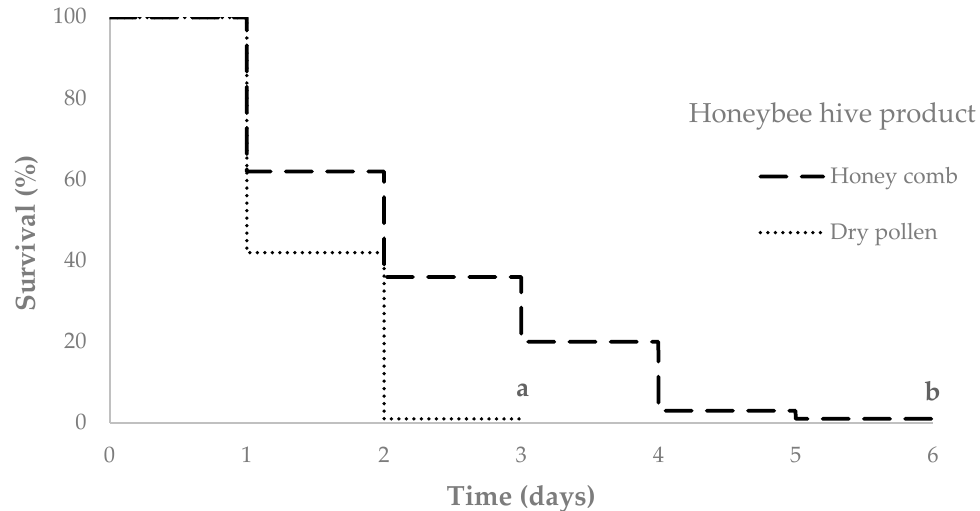
Figure 1. Kaplan-Meier curve displaying the survival of Tropilaelaps mercedesae mites associated with honeycomb and dry pollen in the absence of honeybees. Significant differences are indicated by different letters (a,b, Log Rank test, χ 2= 33.237, df = 1, p < 0.0001).